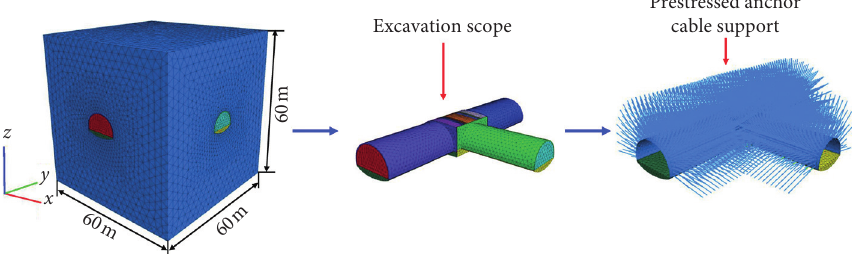
Figure 7: Numerical model of tunnel intersection. Table 1: Computation parameters of materials.